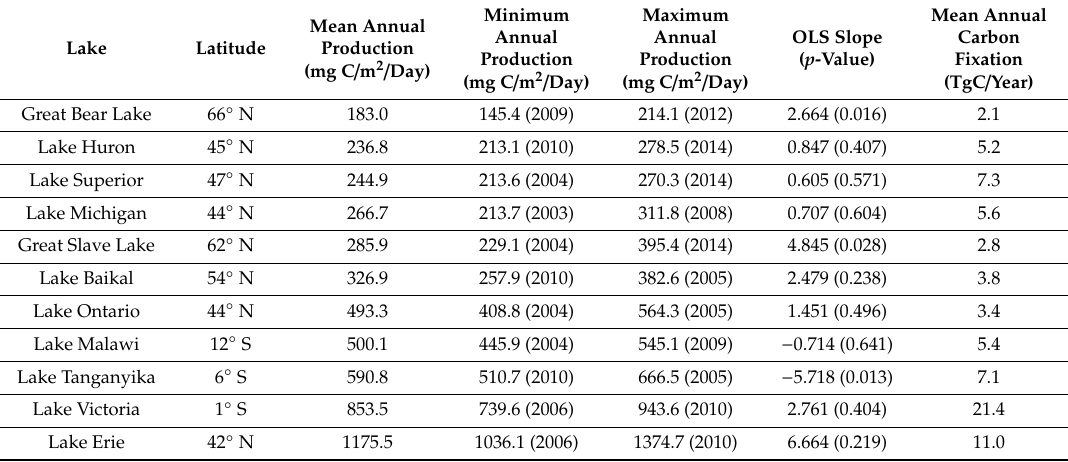
Table 4. Mean, minimum, and maximum annual production by lake, sorted by mean annual production (low to high). The ordinary least squares (OLS) slope of the 16-year time series is also included as well as the mean annual carbon fixation estimate.